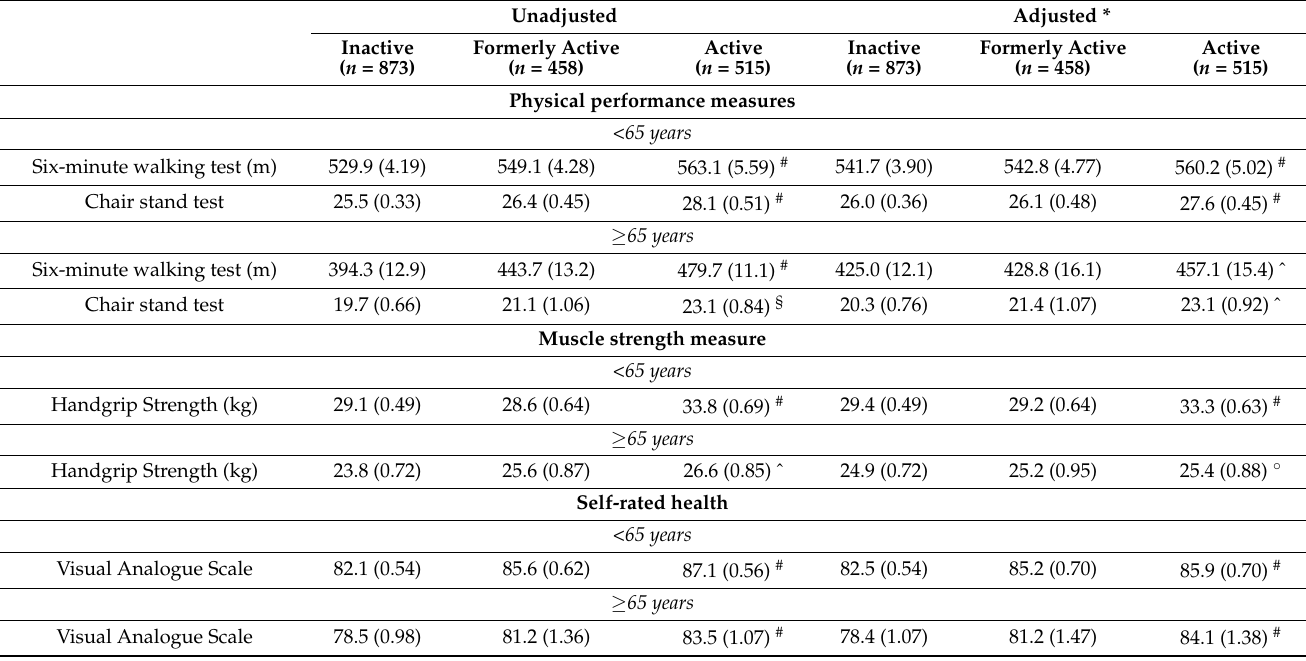
Table 3. Unadjusted and adjusted * means of physical performance, muscle strength measures, and self-rated health in participants younger than 65 years or 65 years and older according to physical activity levels. Unadjusted Adjusted * Inactive ( n =